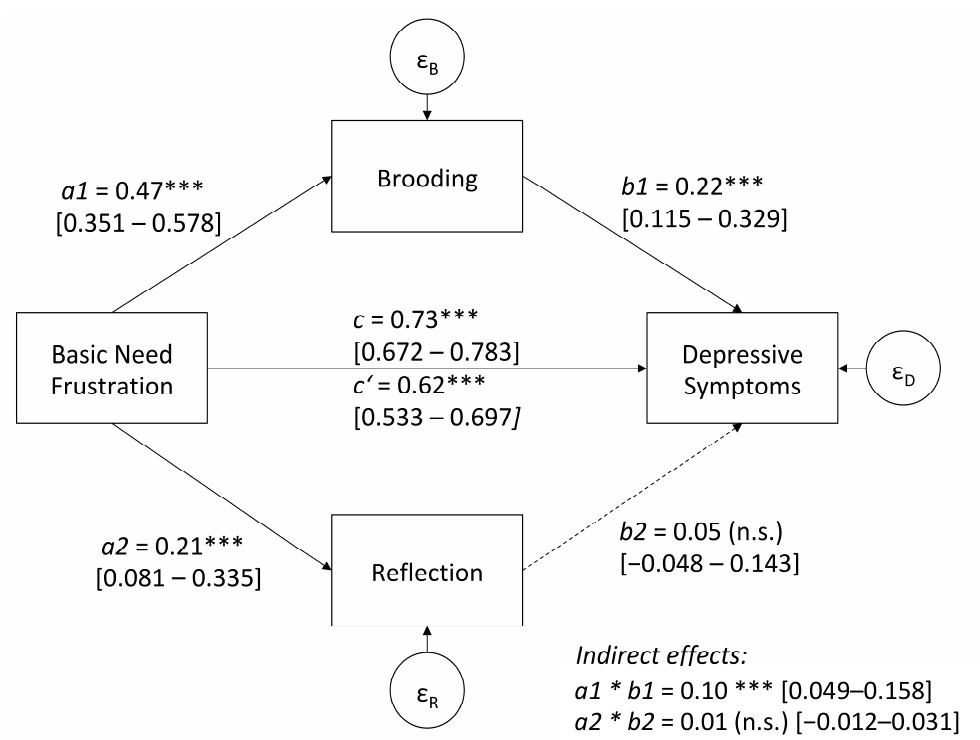
Figure 1. Multiple mediation model; standardized 95% confidence intervals are presented in square brackets; *** p < 0.001